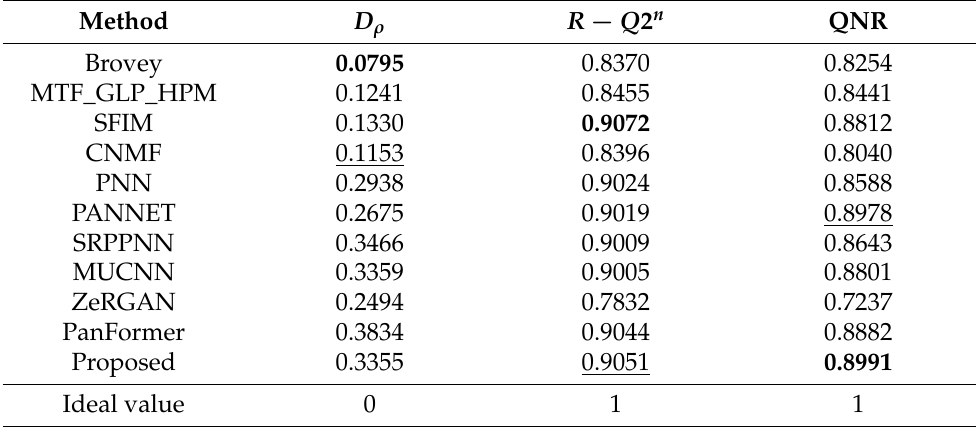
Table 4. Quantitative results of compared methods on the WV3 dataset at full resolution. The best values are shown in bold, and those in second place are underlined.